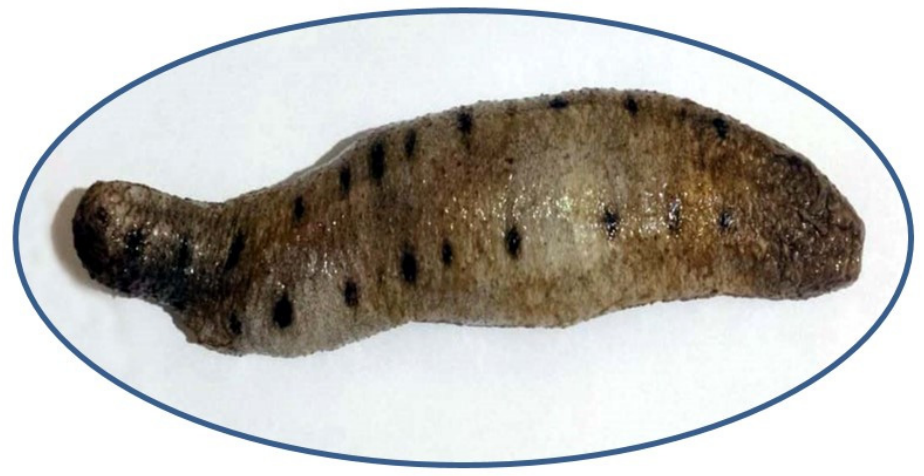
Figure 1. Sea cucumber; Holothuria impatiens . Kingdom: Animalia, Phylum: Echinodermata, Class: Holothuroidea, Order: Holothuriida, Family: Holothuriidae, Holothuria ( Thymiosycia ) impatiens (Forsskål, 1775).